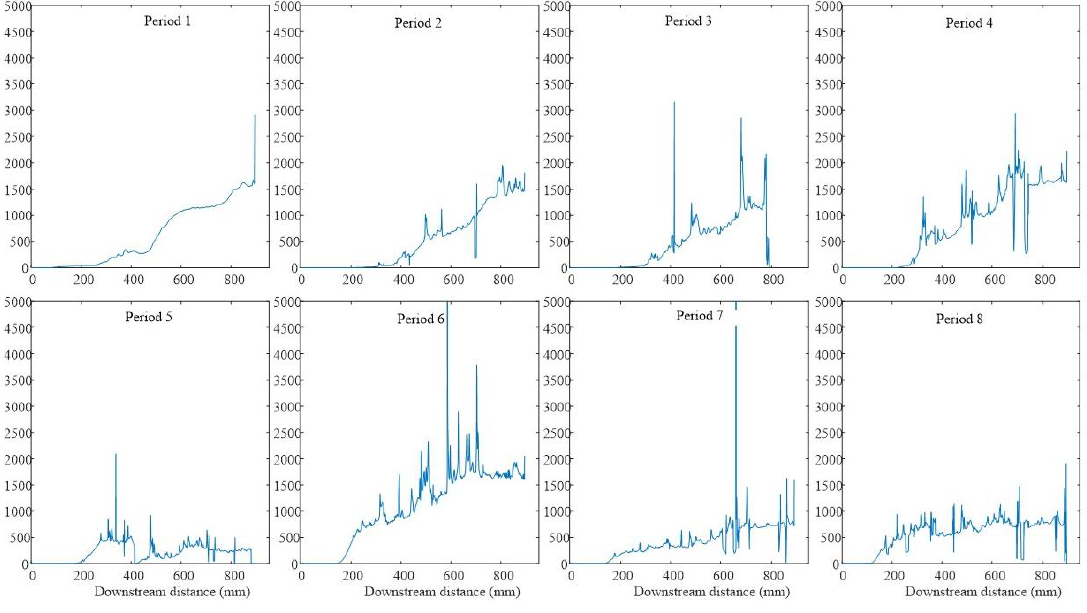
Figure 4 . 1-D sediment transport.